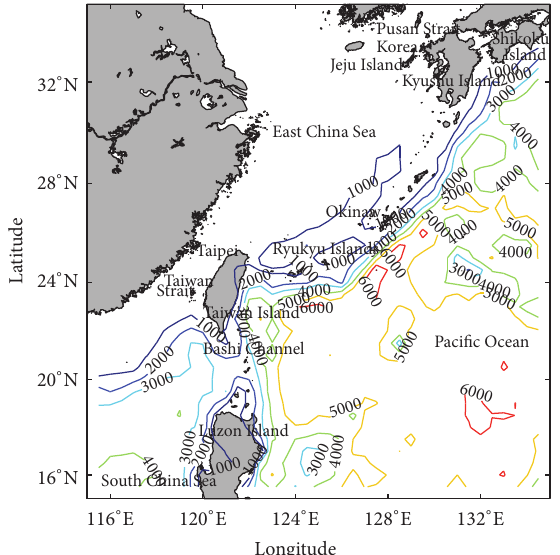
Figure1:TopographyoftheEastChinaSeaandsurroundingwaters.